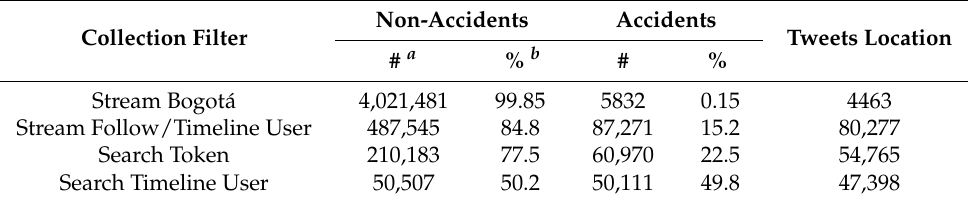
Table 13. Number of tweets classified as TA/NTA according to collection filter; and number of tweets extracted with location